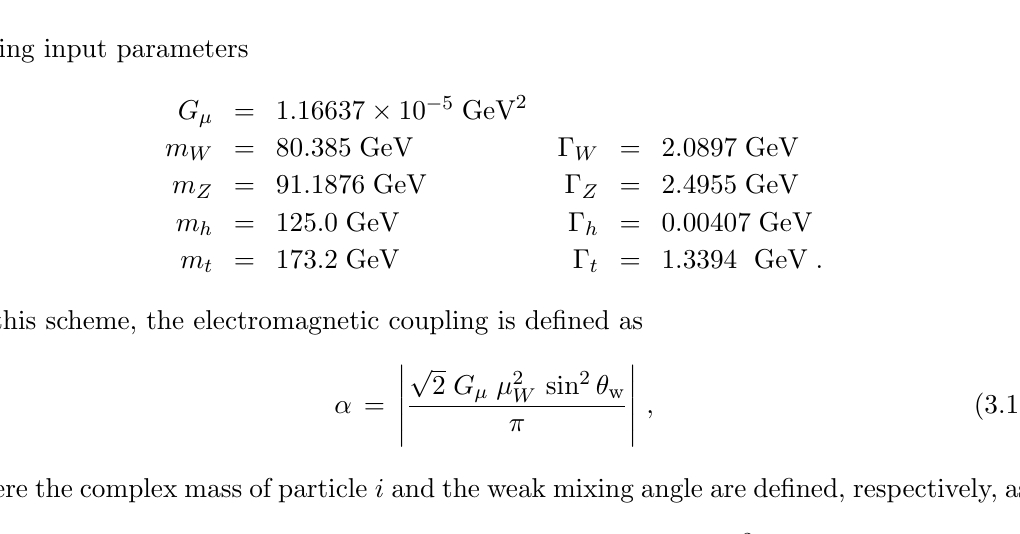
Table 3 . De(cid:12)nition of the (cid:12)ducial region. All selection cuts are applied to dressed leptons, de(cid:12)ned with (cid:1) R dress = 0 :